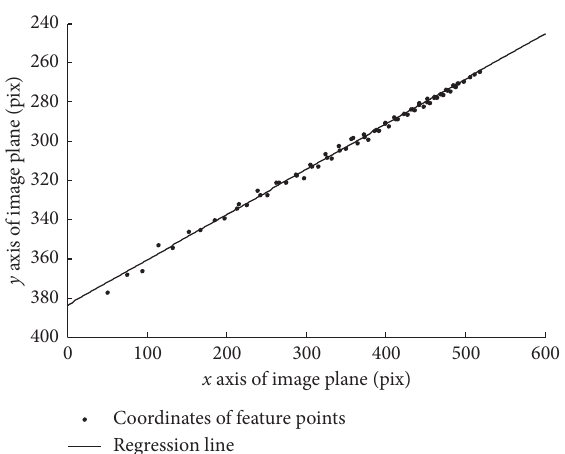
Figure 20: Coordinates and linear regression of 75 feature points.